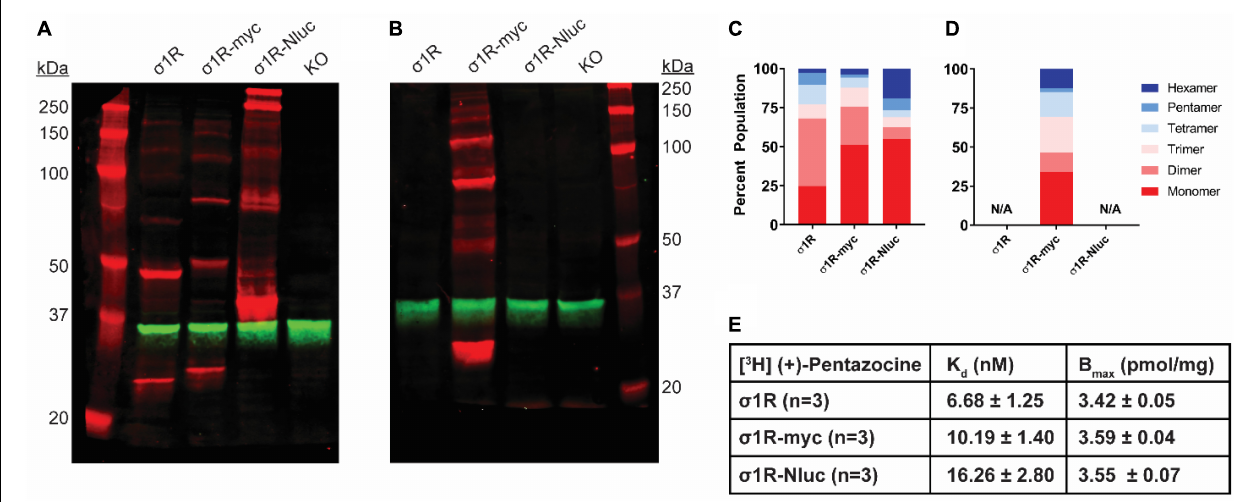
FIGURE 1 | SDS-PAGE mobility comparison among the unmodified and C-terminally tagged σ 1R constructs. (A,B) Red bands are visualized by anti- σ 1R (A) or anti-myc (B) antibodies on 10% SDS-PAGE (protein standard, σ 1R, σ 1R-myc, σ 1R-Nluc, σ 1R KO cells). Anti-GAPDH bands are shown in green for equal loading. (C,D) Quantification of band intensities normalized to total signals within each lane for σ 1R (C) and myc (D) blots. The intensities of bands up to hexamer were normalized to the total summation of the densities within the same lane. Due to a close migration pattern in a 10% polyacrylamide gel, higher order bands past hexamer were not resolvable for quantifications. (E) Radioligand binding properties of [ 3 H] (+)-pentazocine for σ 1R, σ 1R-myc, and σ 1R-Nluc (averaged curves are shown in Supplementary Figure S4 ). K d and E max values are not statistically different (one-way ANOVA). Each blot image is representative of n > 3 experiments that are averaged in bar